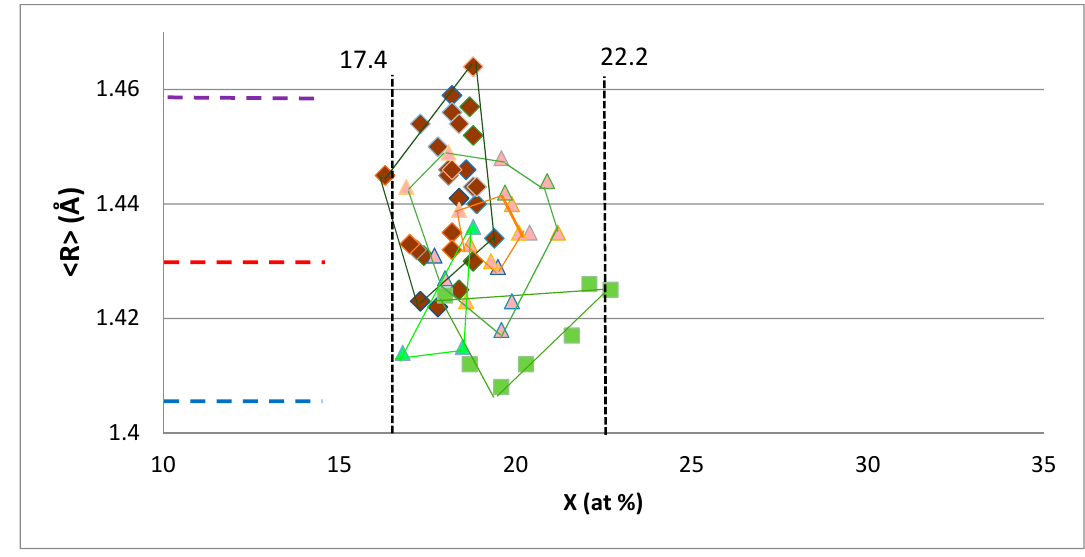
Figure 5. <R> versus concentration of X in A15–Nb 3 X where Nb is substituted by Cr, Fe, Hf, Mo, Ti, W, and X = Al, Ge, Si, Sn. Data for A15–Nb 3 X with X = Si, Sn is shown by brown diamonds, data for X = Si, Sn, Al with rose triangles, data for X = Ge, Si, Sn with green triangles and data for X = Al, Ge, Si or Sn with green squares. For vertical and dashed lines, see text.